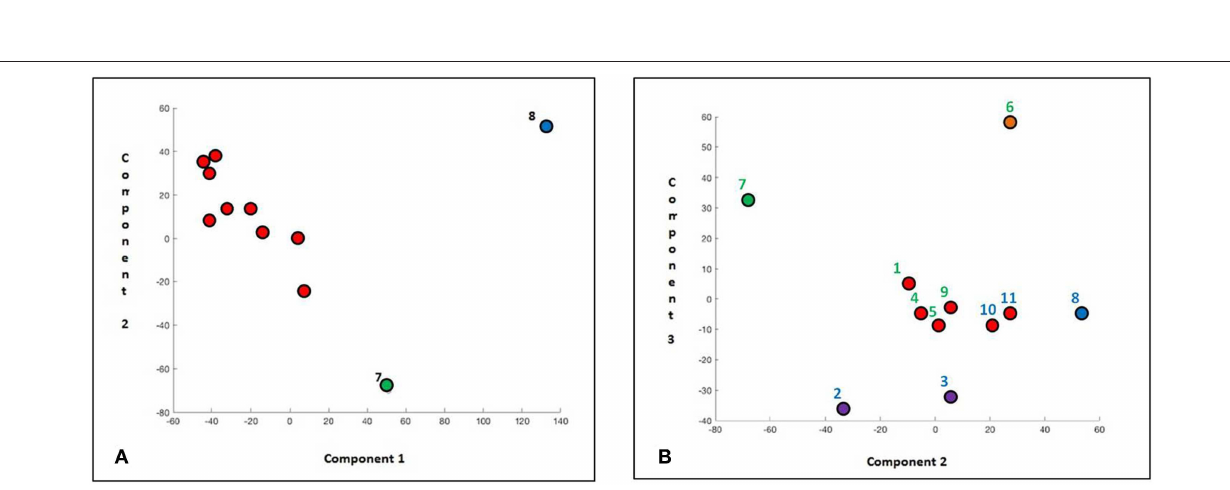
Frontiers in Oncology |